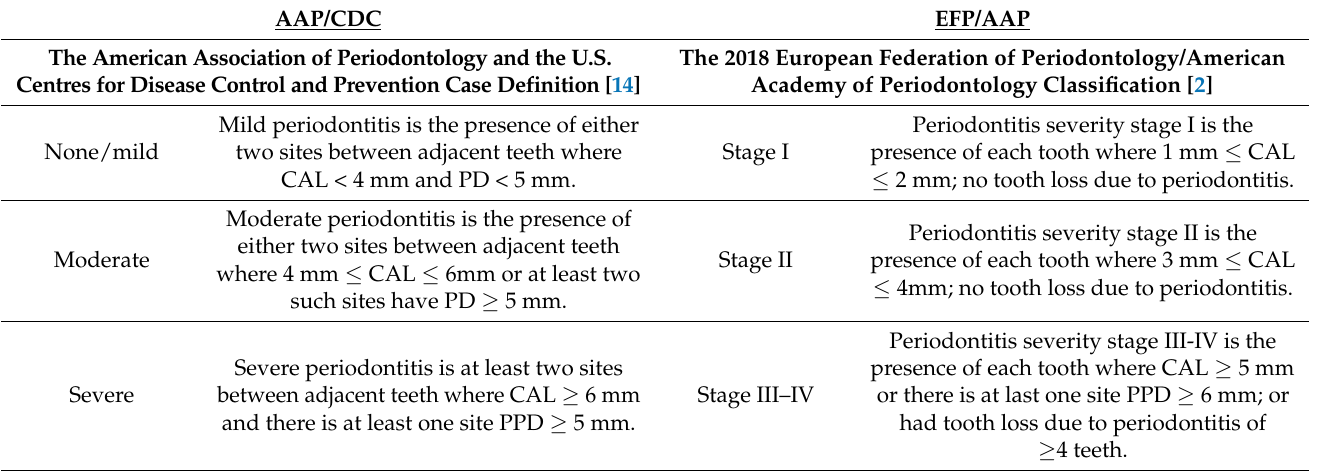
Table 1. Different periodontal disease case